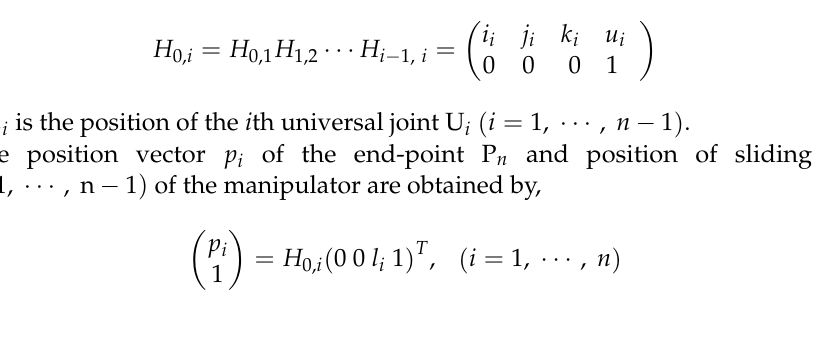
Figure 16. TakoBot kinematic structure. Multiplying the H-matrices successively, we obtain unit vectors and the position vector of the i th coordinate